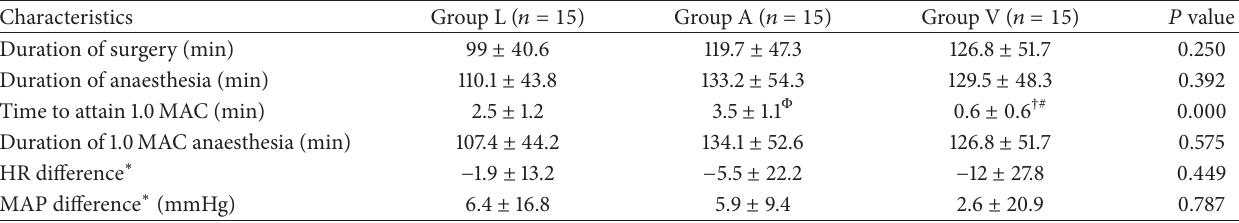
Table 2: Intraoperative